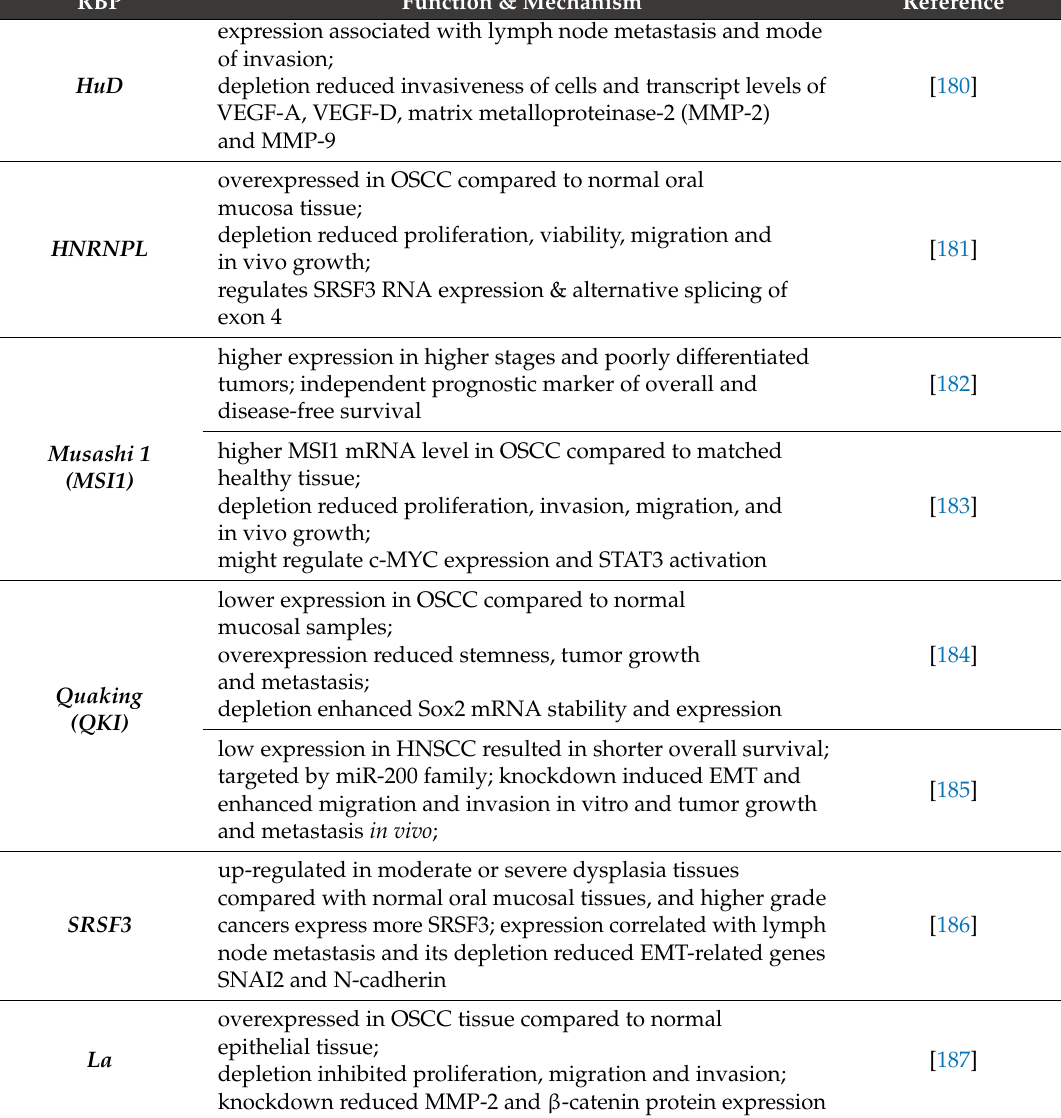
Table 1. Additional RBPs with a role in oral cancer cell migration, invasion, and